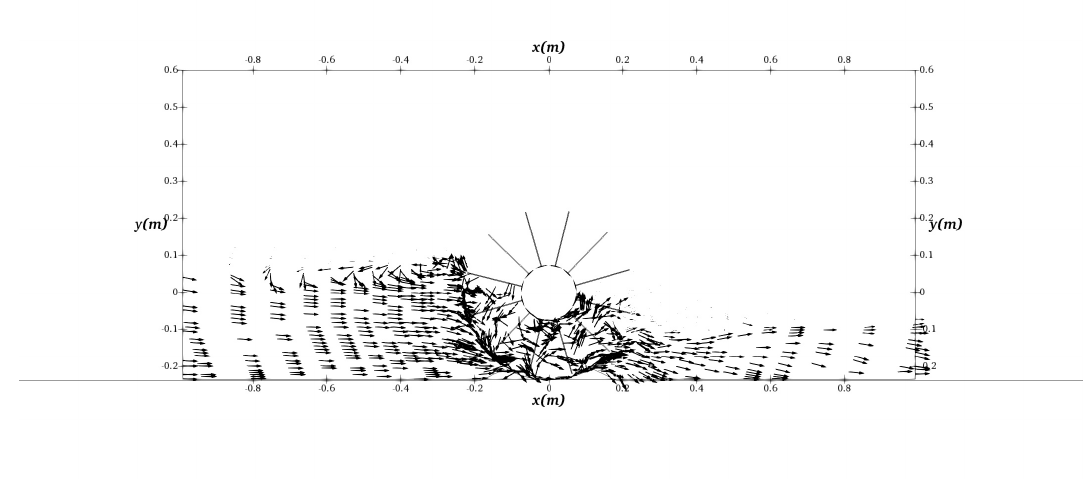
Figure 17. Velocity vectors of the slice view at the midsection of the channel, at t = 4.0